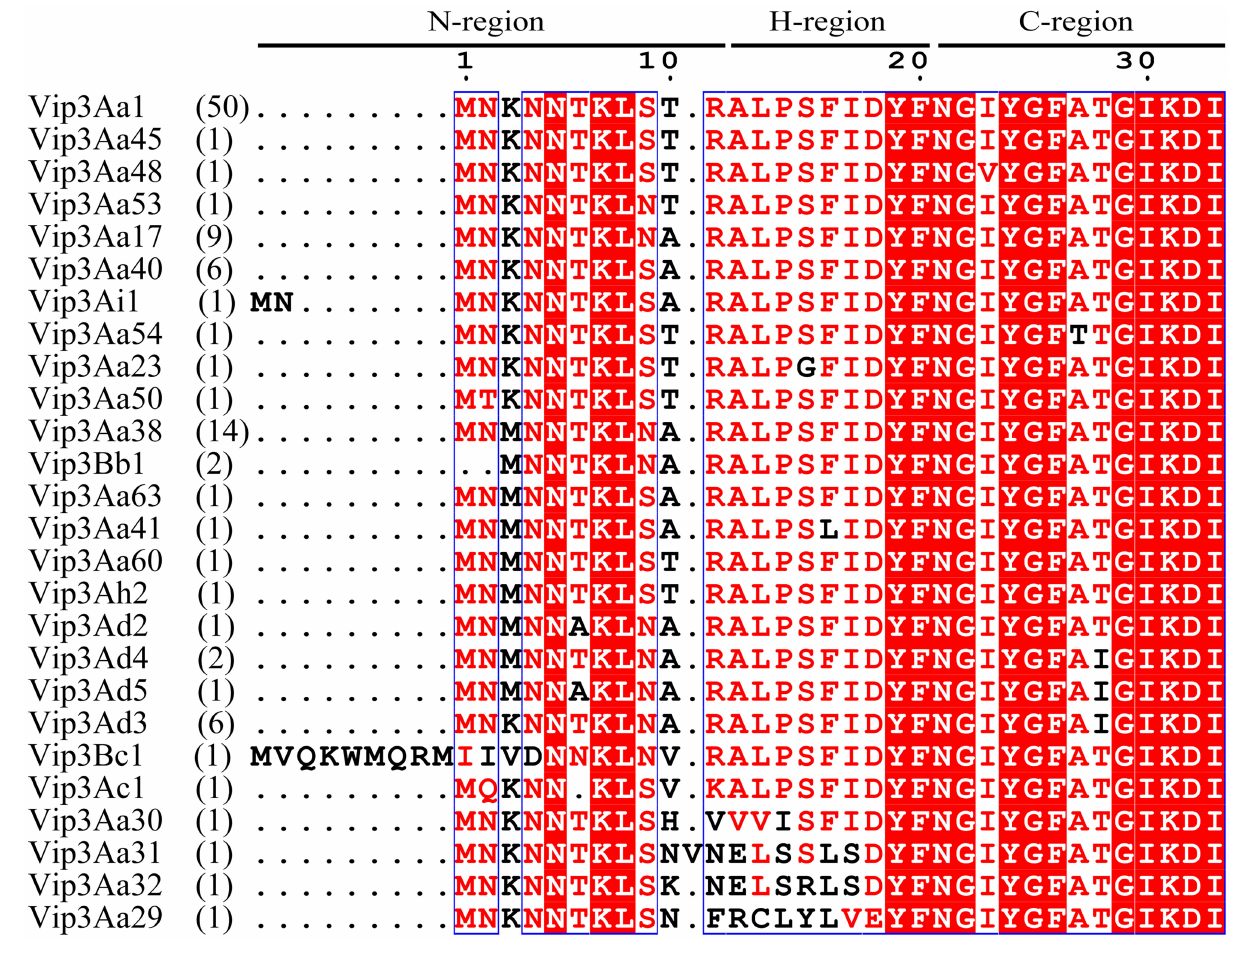
Frontiers in Microbiology |